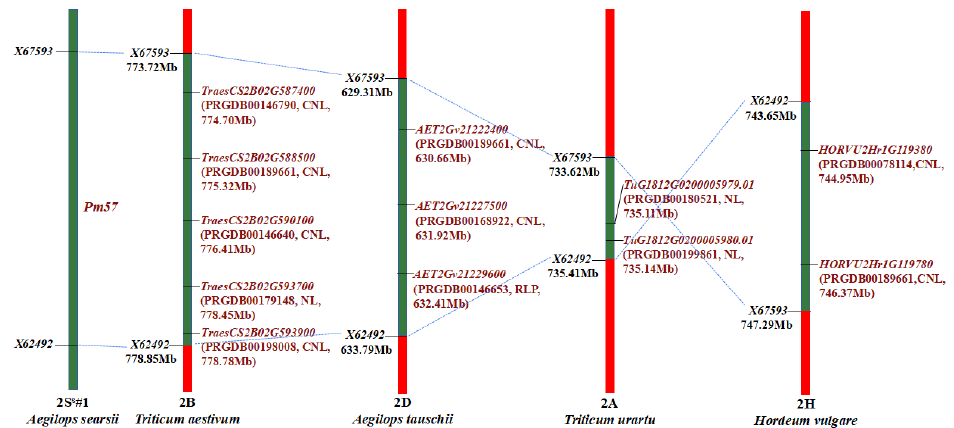
Figure 6. Comparative analysis of Pm57 syntenic region and R-genes in T. aestivum , Ae. tauschii , T. urartu , H. vulgare . Syntenic blocks on each chromosome are displayed in green. Markers flanking synteny regions are on the left; names, classes, and genomic positions of the R-genes are on the right of each chromosome. Chromosome inversion was observed in this region-based markers X67593 to X62492 at chromosome 2H of H. vulgare when compared with all other species.